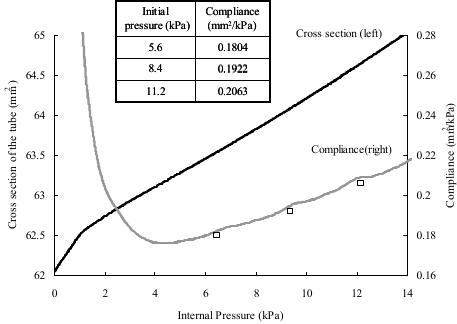
Fig. 4 Static relation between pressure and cross-section of the silicone